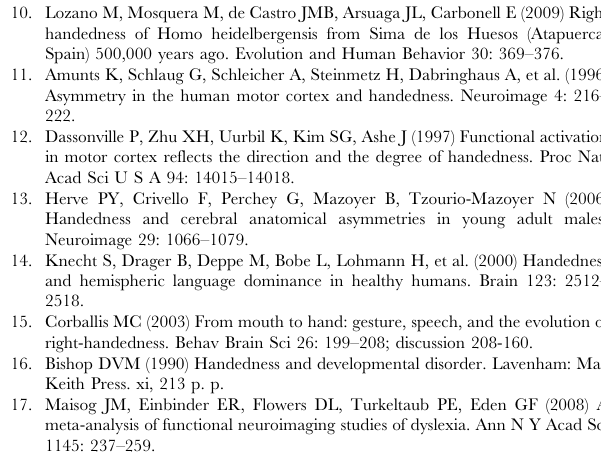
b = effect size (standard deviation shift per copy of the effect allele, 95 percent confidence intervals included), SE= standard error. Table S3 Fifteen phenotypes that contain between 10 and 100 genes, and cause asymmetry defects when knocked out in mice, were tested using MAGENTA for an enrichment of SNPs with low P values. The observed number of genes were compared to the expected using a cut-off that equals the 95 th percentile of all gene P values (compare to the 75 th percentile cutoff in Table 4). P values were then adjusted for multiple testing using an FDR correction. Table S4 After removing the known association in PCSK6 from the analysis, in the relative hand skill GWAS meta-analysis of individuals with reading disability, there remains an over- representation of highly associated SNPs within human orthologs of genes involved in causing LR asymmetry phenotypes when knocked out in mice. Fifteen phenotypes that contain between 10 and 100 genes, and cause asymmetry defects when knocked out in mice, were tested for an enrichment of SNPs with low P values. We used an enrichment cut-off that equals the 75 th percentile of all gene P values. P values were then adjusted for multiple testing using an FDR correction. Table S5 In the relative hand skill general population GWAS, there is an over-representation of highly associated SNPs within human orthologs of genes involved in causing LR asymmetry phenotypes when knocked out in mice. We tested four phenotypes that contain between 10 and 100 genes, causing asymmetry defects when knocked out in mice, and showed enrichment of SNPs with low P values in the RD cohorts meta-analysis. We used an enrichment cut-off that equals the 75 th percentile of all gene P values. P values were then adjusted for multiple testing using an FDR correction. Table S6 In the relative hand skill GWAS meta-analysis of individuals with reading disability, there is an over-representation of highly associated SNPs within human orthologs of genes involved in causing an absent corpus callosum when knocked out in mice. We tested two cerebral phenotypes that are often observed in individuals with ciliopathies for an enrichment of SNPs with low P values. We used an enrichment cut-off that equals